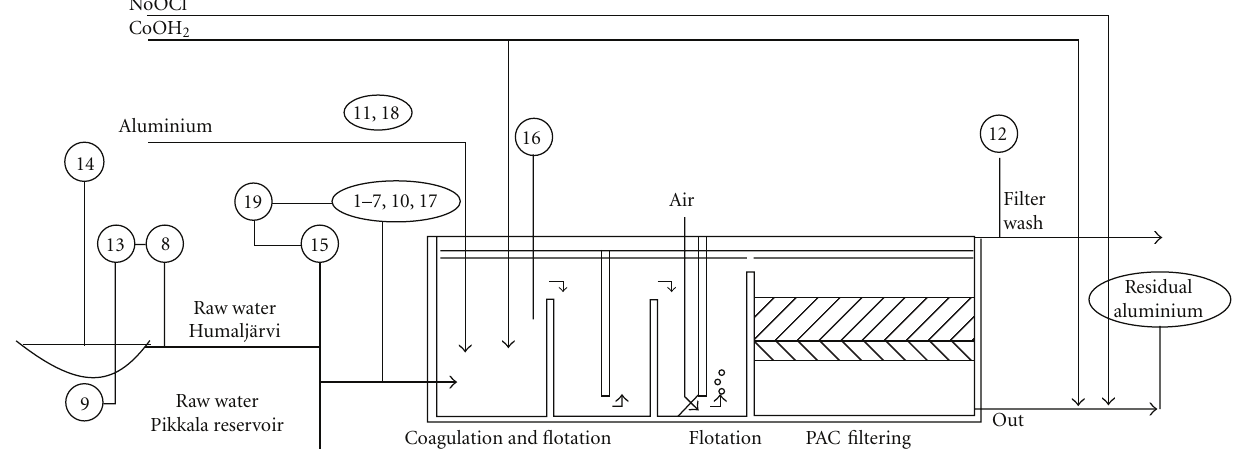
Figure 1: The water treatment process used by Suomen Sokeri. The numbers refer to the measuring points for the variables (see Tables 1 and